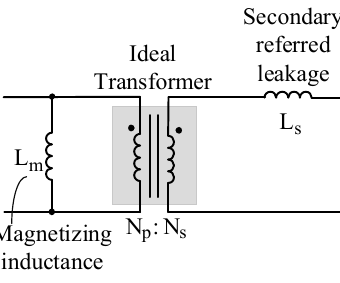
Figure 3. Flyback transformer secondary leakage.